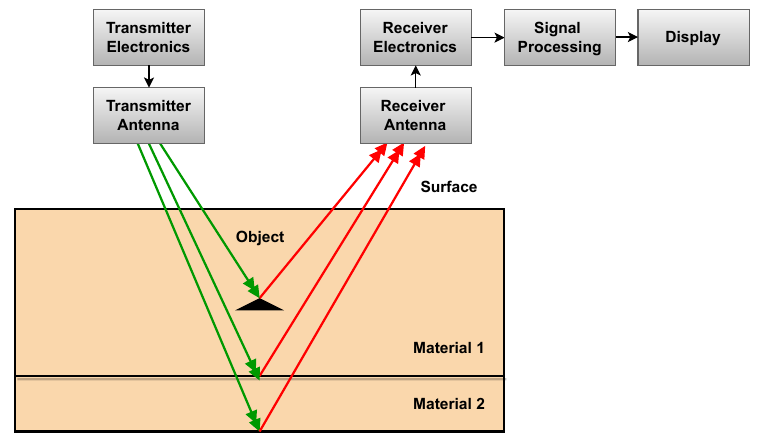
Figure 8. Scheme of GPR